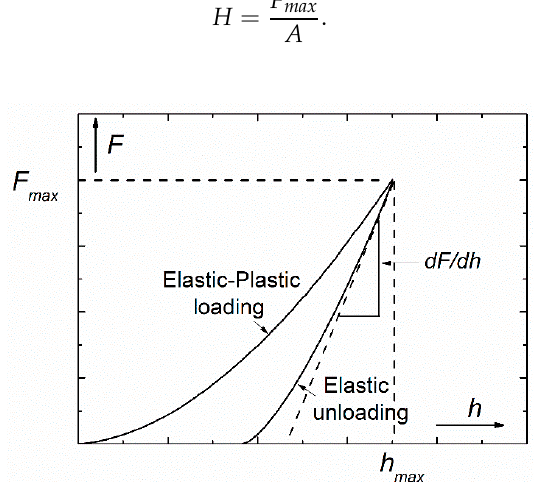
Figure 1. Schematic load-depth ( F-h ) indentation curve with some characteristics necessary for the determination of hardness and elastic modulus.